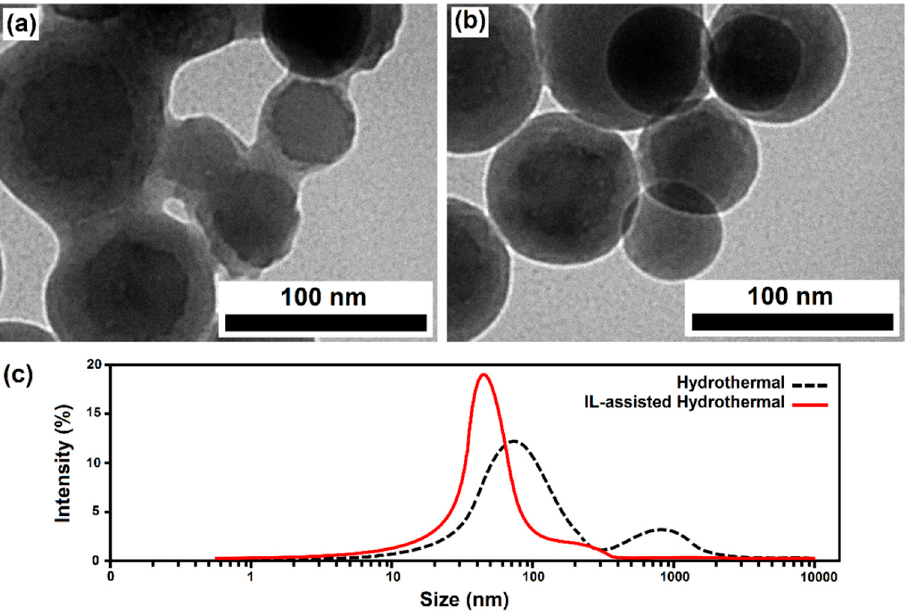
Figure 5. TEM images (( a ) without ILs and ( b ) with ILs) and particle size distribution ( c ) of the as-prepared products via the hydrothermal method, without and with ILs.